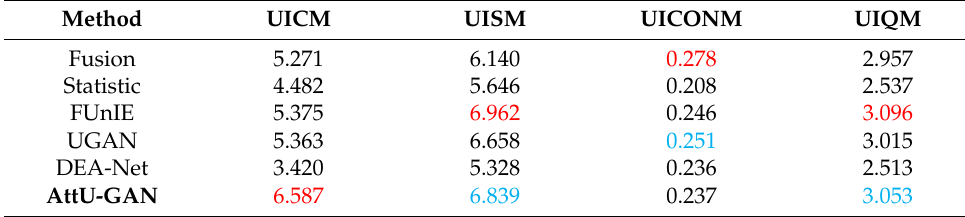
Table 3. No-reference image quality evaluation